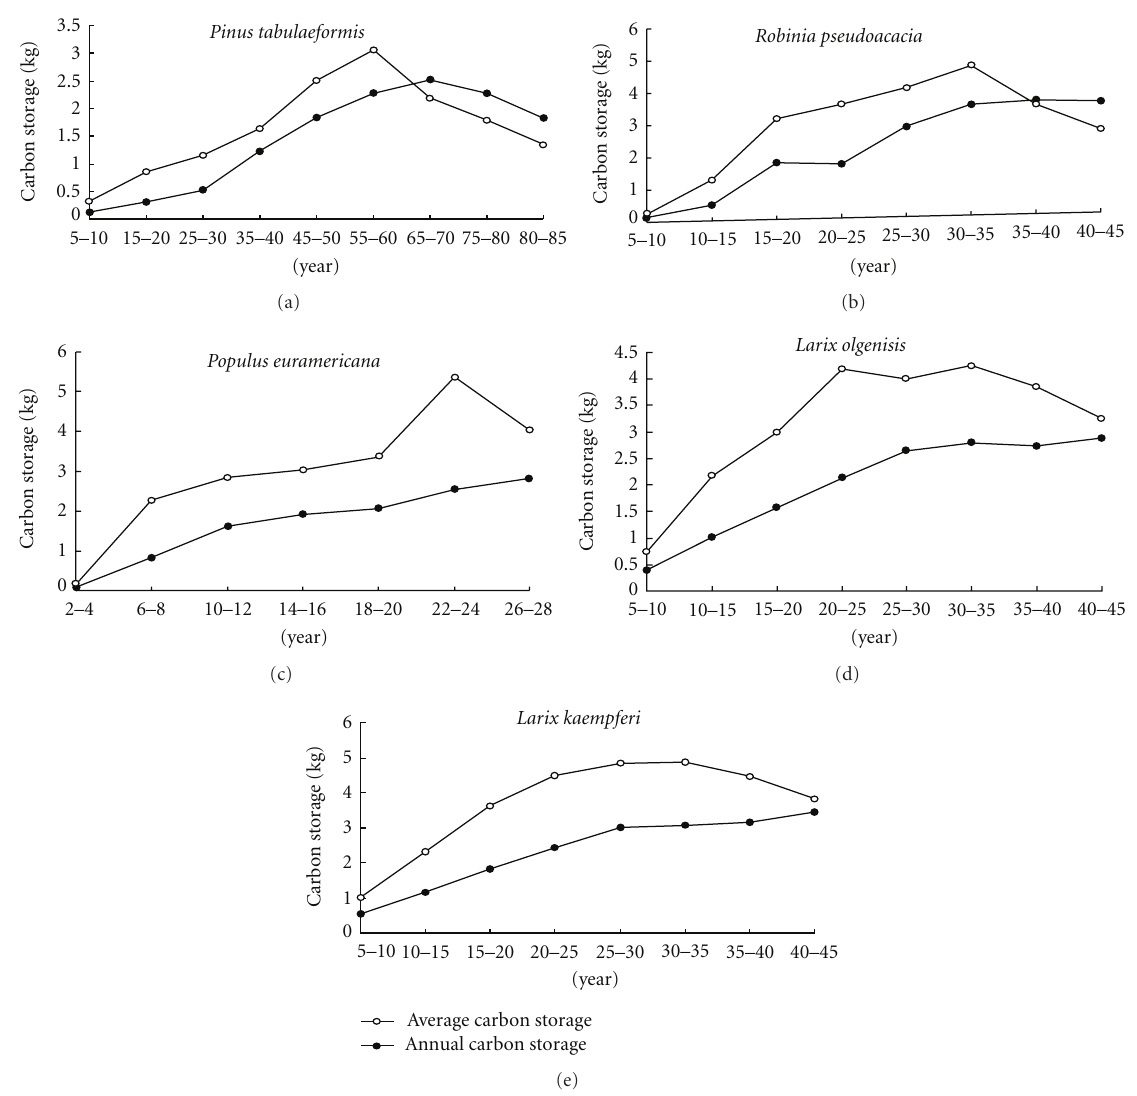
Figure 1: The growth curve of annual carbon storage and average carbon storage of five tree